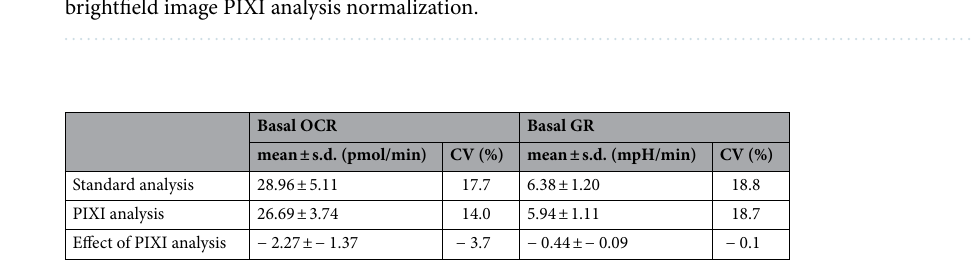
Table 2. Effects of PIXI analysis on the variation between PBMC donors. PBMCs were isolated from sixteen healthy lean individuals (females, 18–25 years of age, BMI 18.5–25 kg/m 2 ) and plated at 75–300 × 10 3 cells/ well (n = 3–4) to generate a calibration curve that was used to transform total pixel intensity values into PIXI analyzed cell numbers. XF assay measurements were performed at 225 × 10 3 cells/well (n = 8) and basal OCR and basal GR levels were normalized against the number of plated cells (standard analysis) or PIXI analyzed cells (PIXI analysis). Here a summary of the changes in group mean, s.d. and CV for basal OCR and basal GR after standard analysis or PIXI analysis is